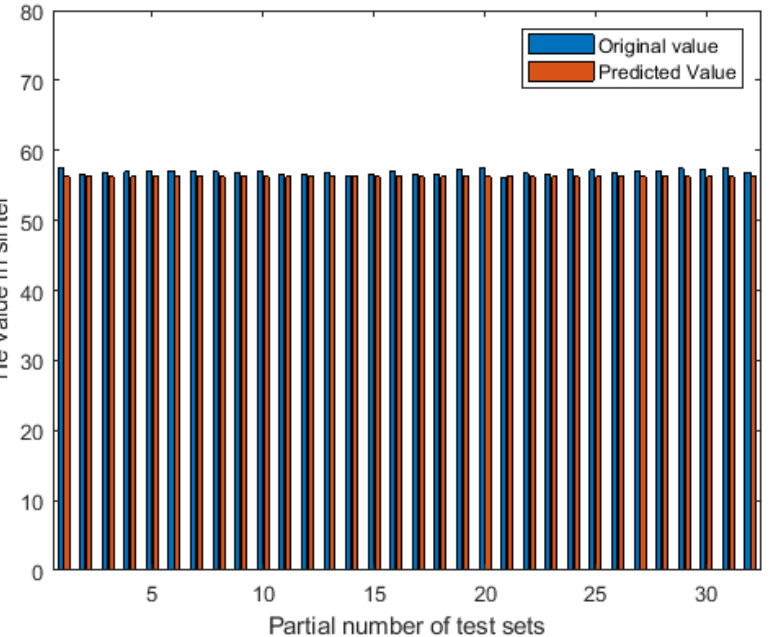
Figure 4. Comparison of the actual Tfe component and the predicted Tfe component with our SCORN model. The max error is ± 1.4835.